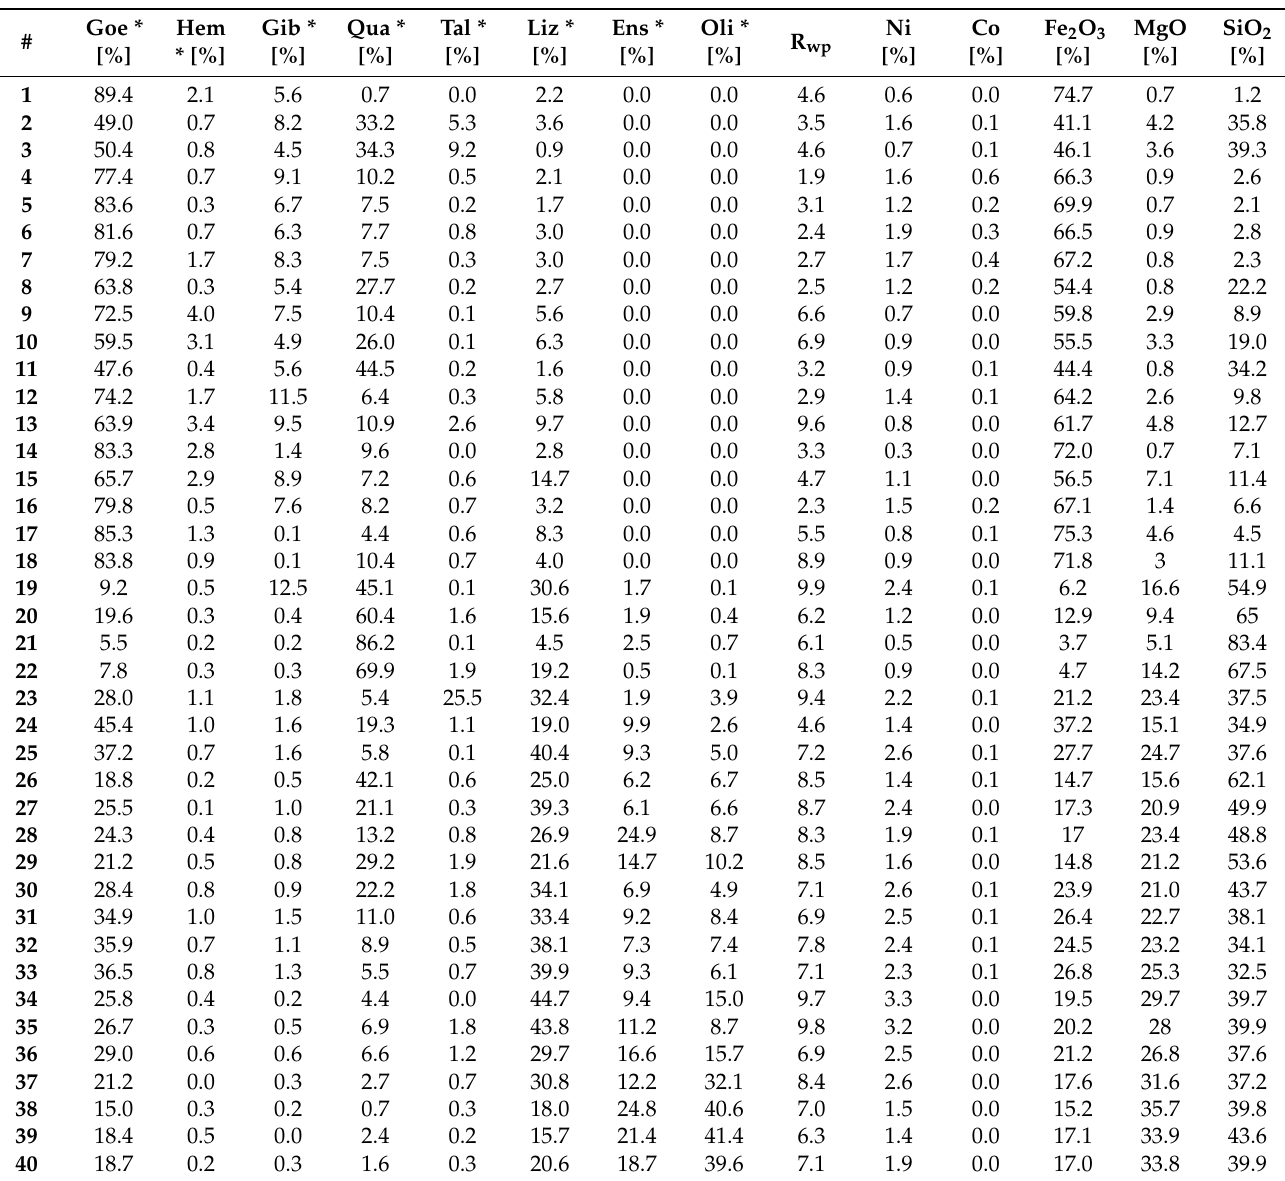
Table 3. Mineral composition determined using the Rietveld method, R wp value of the quantification and main elements analyzed with XRF.